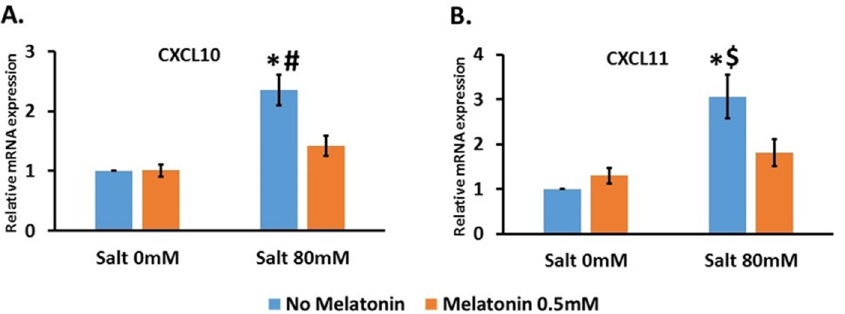
Figure 4. Salt upregulated CXCL10 and CXCL11 expression in mesangial cell line where melatonin treatment downregulated its expression. RMC (rats’ mesangial cell line) were treated with salt 80 mM with and without 0.5 mM melatonin. CXCL10 ( A ) and CXCL11 ( B ) were upregulated by salt treatment and the addition of melatonin reduce this upregulation. The graphs present 6 independent trials. *- p ≤ 0.001 versus control #- p ≤ 0.005 versus salt 80 mM and melatonin 0.5 mM. $- p ≤ 0.05 versus salt 80 mM and melatonin 0.5 mM.